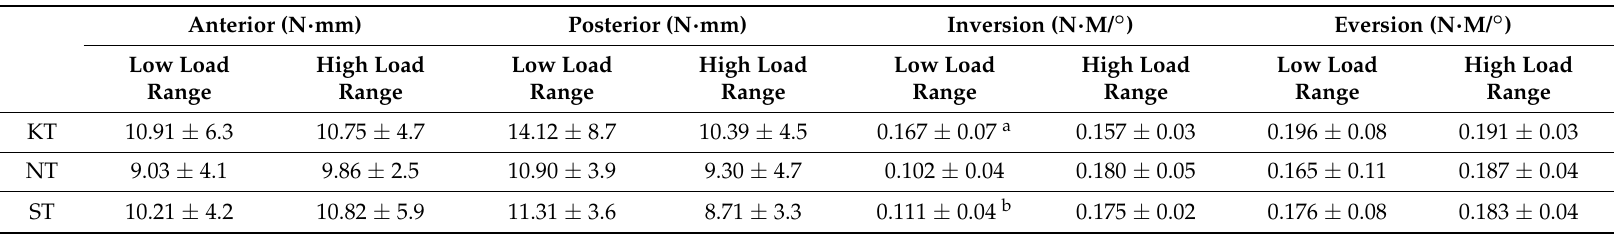
Table 2. Arthrometric Measurements of Ankle Complex Stiffness in Low-Load Range and High-Load Range by Support